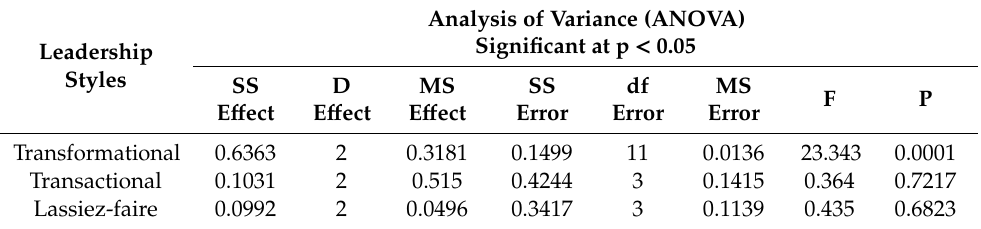
Table 4. ANOVA test for significant di ff erences in leadership style amongst the three projects.